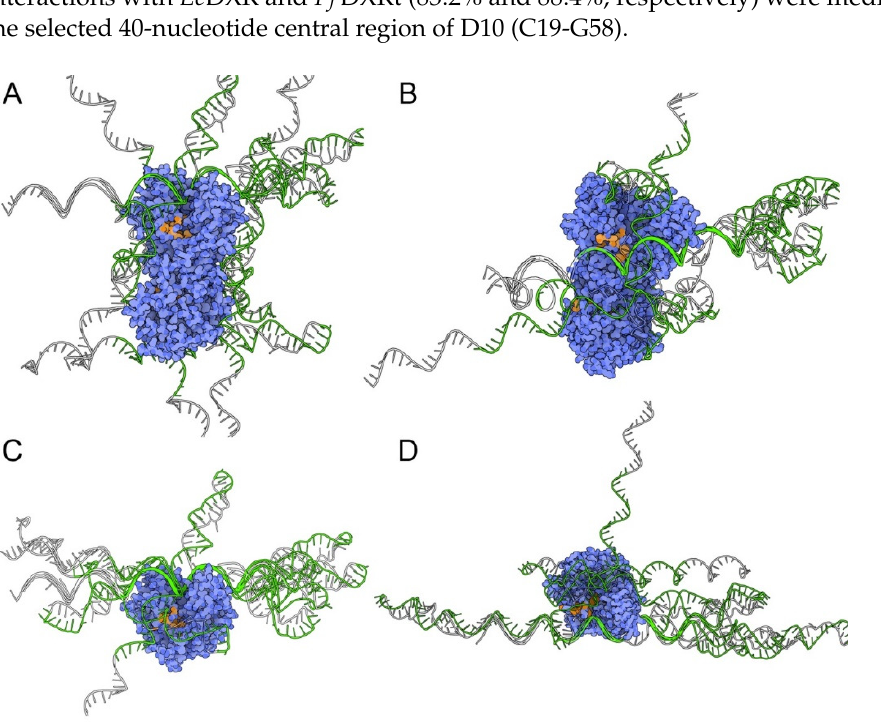
Figure 6. Computational simulations to depict the most favorable D10-DXR interactions. Top 10 energetically favorable D10 (colored green) docking for DXR (colored blue) for the homodimeric active enzyme found in the cell of ( A ) Ec DXR (PDB code 1Q0Q) and ( B ) Pf DXRt (PDB code 5JMW) and their respective monomeric forms ( C , D ), which were used in the SELEX cycles. The enzyme active site cavity is colored orange. Data for delimiting the active site was obtained from [63–66].